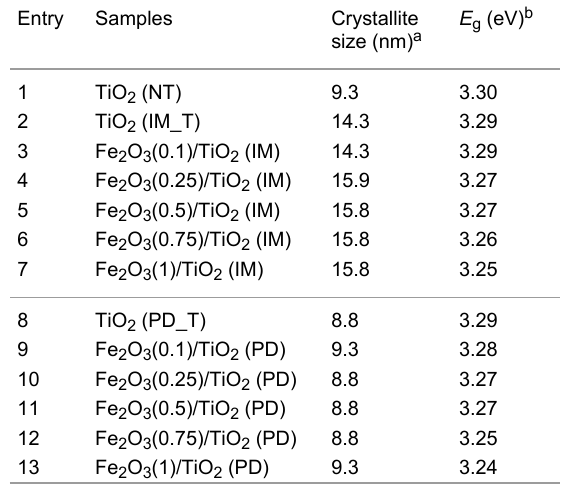
Table 1: Crystallite size and band gap energy ( E g ) of the unmodified TiO 2 and Fe 2 O 3 /TiO 2 nanocomposites prepared by impregnation (IM) and photodeposition (PD) methods. NT represents no treatment and T indicates an additional heat treatment was carried out on the